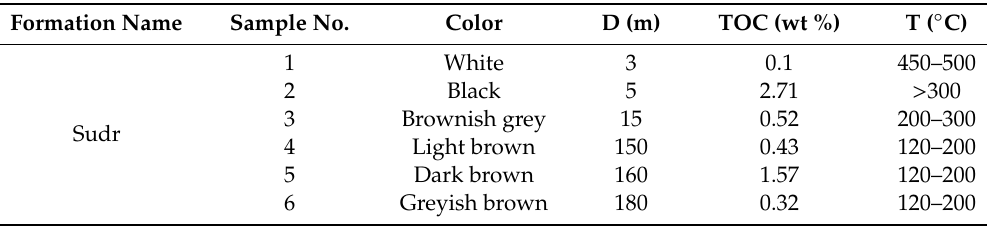
Table 1. Total organic carbon (TOC) values, average temperatures, and colors of the samples from the Wadi Matulla area. (D: distance in meters from the dyke, see Figure 2c, TOC: Total Organic Carbon, T ◦ C: Temperature in